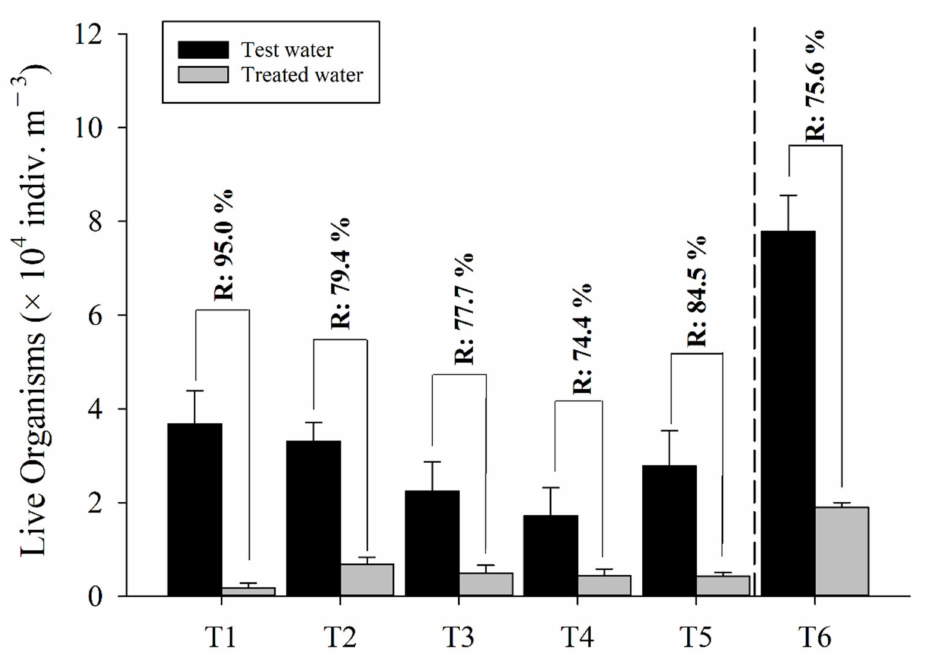
Figure 5. Removal efficiency of zooplankton species treated by GE BWMS pre-treatment system at each test cycle during full-scale test period (R; removal efficiency).